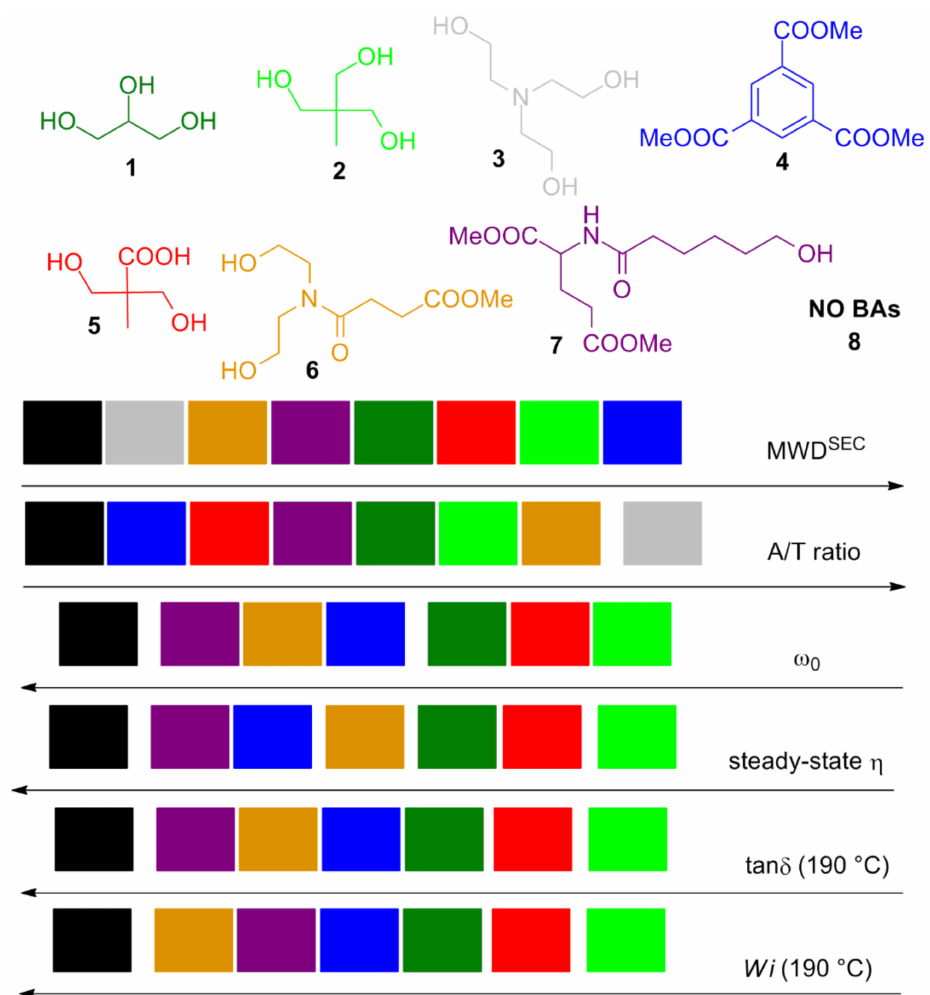
Figure 8. The main characteristics of the PBAT synthesized.